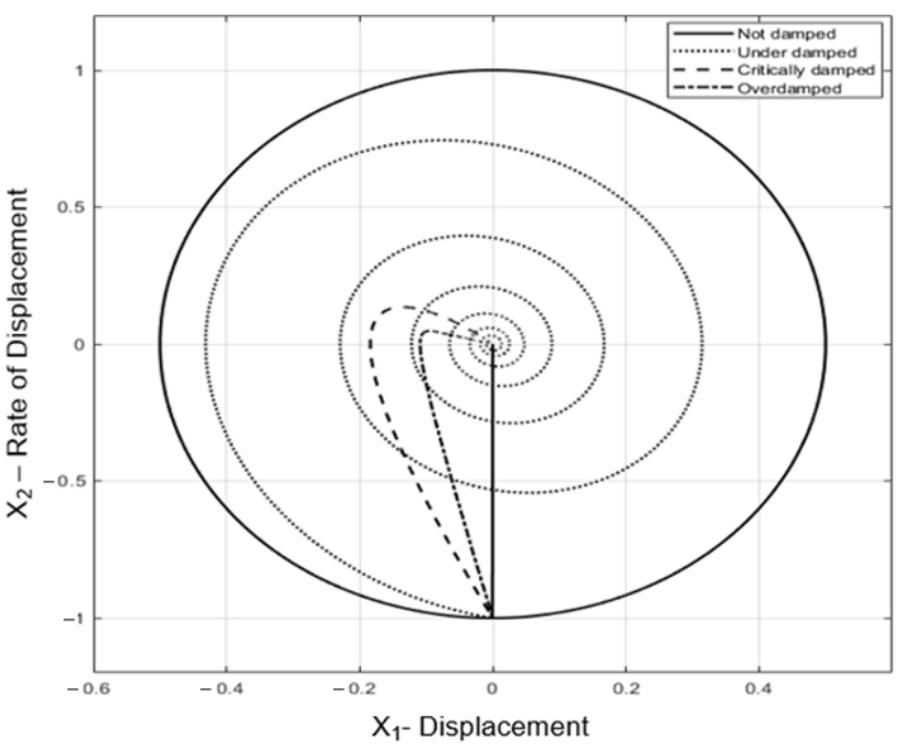
Figure 11. System phase portrait under unit impulse input disturbance and [0, 0] initial conditions (Case example 1).